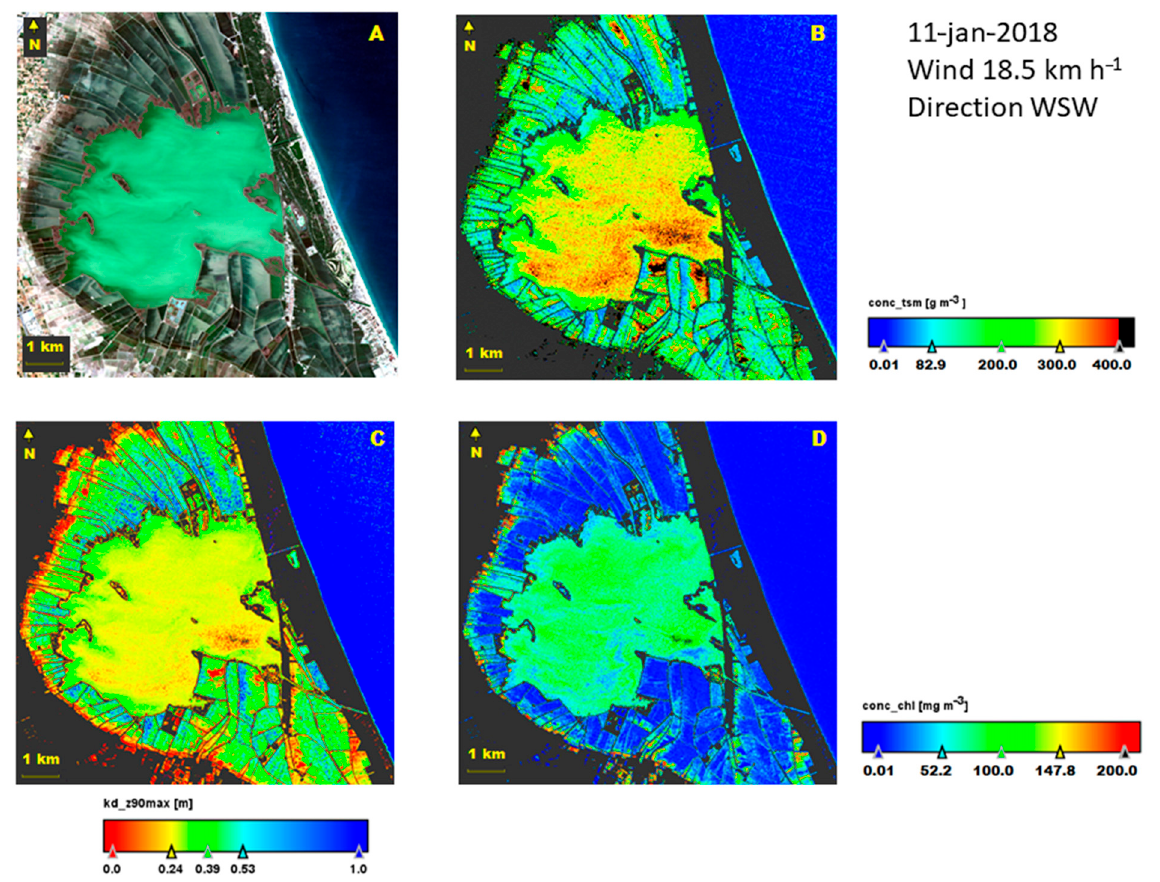
Figure 8. Sentinel-2 image and thematic maps on a westerly windy day. The rice field is flooded, but without vegetation. ( A ) False color RGB; ( B ) TSM concentration map; ( C ) transparency map; ( D ) chlorophyll a concentration map. Note that the scale of TSM is greater than Figure 7.